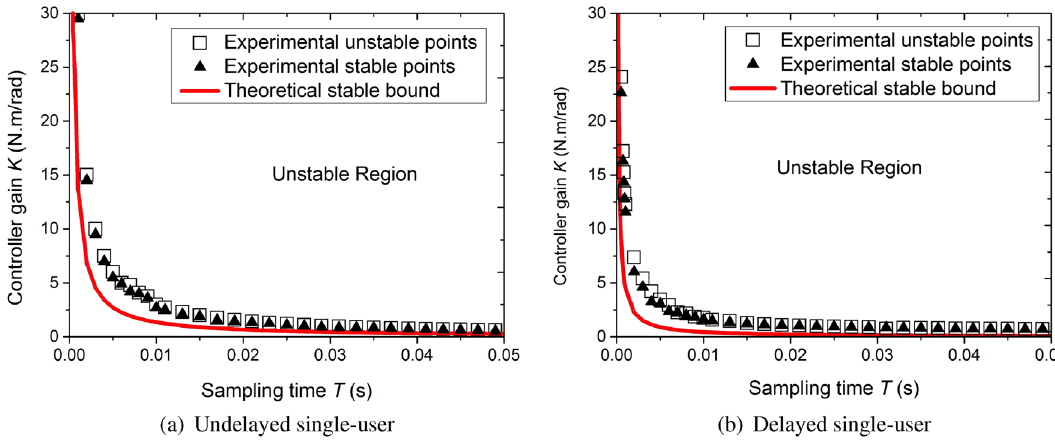
Figure 13. Comparison of theoretical and measured control gains in the virtual haptic surgery simulation